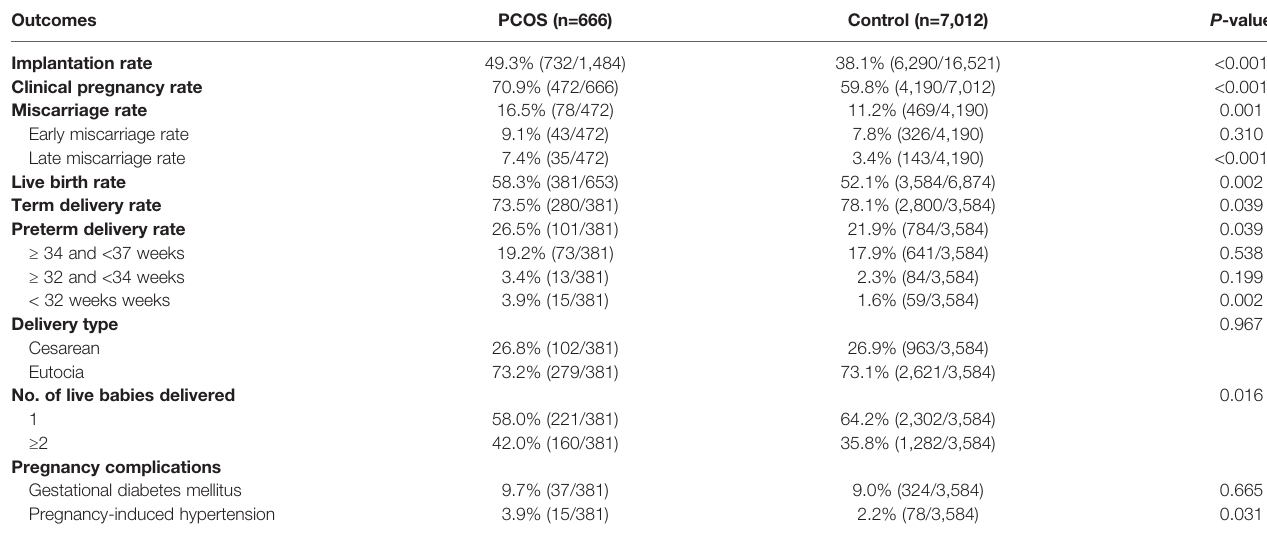
TABLE 2 | Pregnancy outcomes and complications of women with polycystic ovary syndrome (PCOS) diagnosis and controls during their fi rst in vitro fertilization (IVF) treatment cycle. Outcomes PCOS